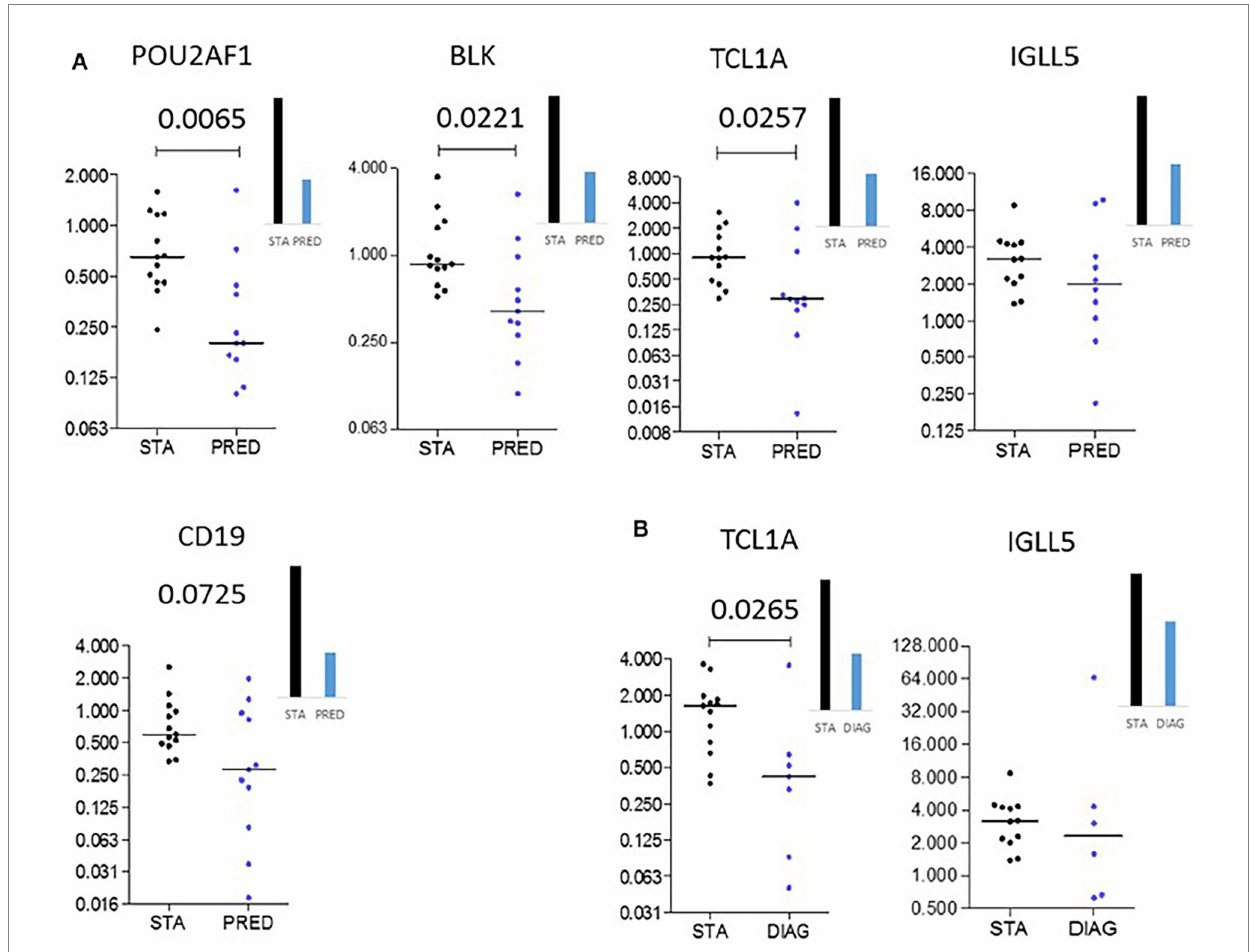
FIGURE 14 Independent validation. Microarray gene expression data (bar histograms) were validated by quantitative PCR in an independent set of patients (dot histograms) comparing STA and PRED (A) and STA and DIAG (B) . Mann–Whitney p values are indicated, adapted from